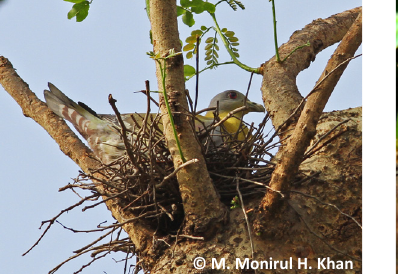
Image 5. Red-vented Bulbul nest